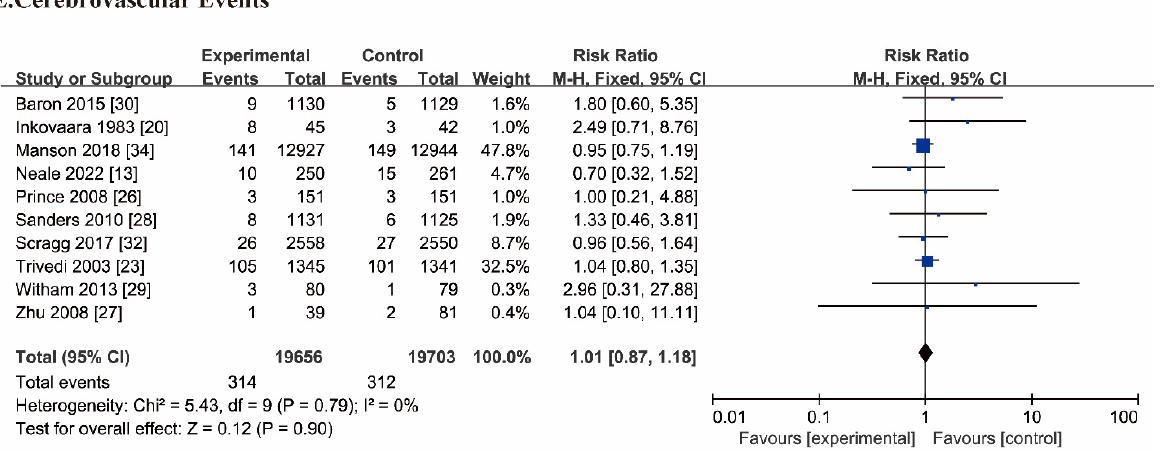
Figure 1. Forest plot comparing the effects of vitamin D on cardiovascular events. For different events, we presented in different rows in forest plots. A. cardiovascular mortality; B. stroke; C. myocardial infarction; D. cardiovascular events; E. cerebrovascular events. The black line represents the 95% confidence interval of each study. The blue box represents the weight of each study. The black diamond refers to results in pooled analysis. [12,13,20,21,23,25–37]